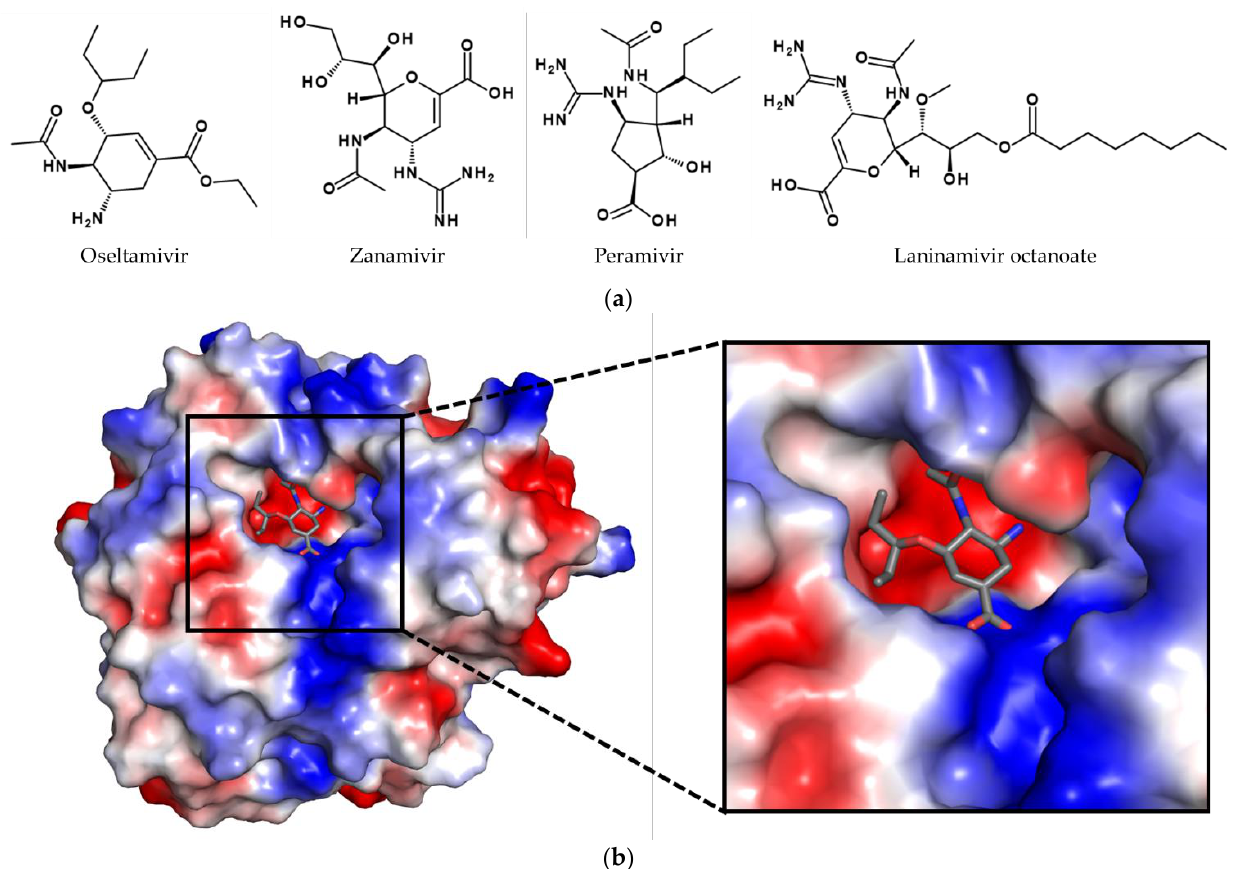
Figure 4. Structures of approved NA inhibitors. ( a ) Structures of oseltamivir, zanamivir, peramivir, and laninamivir octanoate. ( b ) Crystal structure of oseltamivir (shown as sticks with grey carbon atoms, oxygen in red, and nitrogen in blue) in the binding cleft of a N1 NA. The surface of the NA was colored according to is calculated negative ( − 58 kT/e, red) and positive (+58 kT/e, blue) electrostatic potential. The structure was determined by X-ray crystallography (10.2210/pdb2HU0/pdb) [38]. The figure was generated with PyMOL Molecular Graphics System Version 2.0 (Schrödinger, LLC, New York, NY, USA).